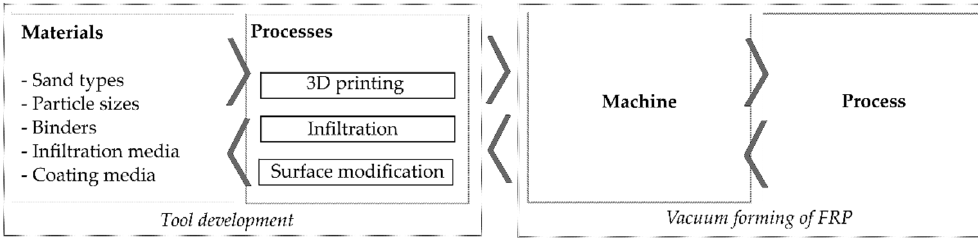
Figure 7. Investigation approach targeting the fabrication of sand tools for vacuum forming of FRP.